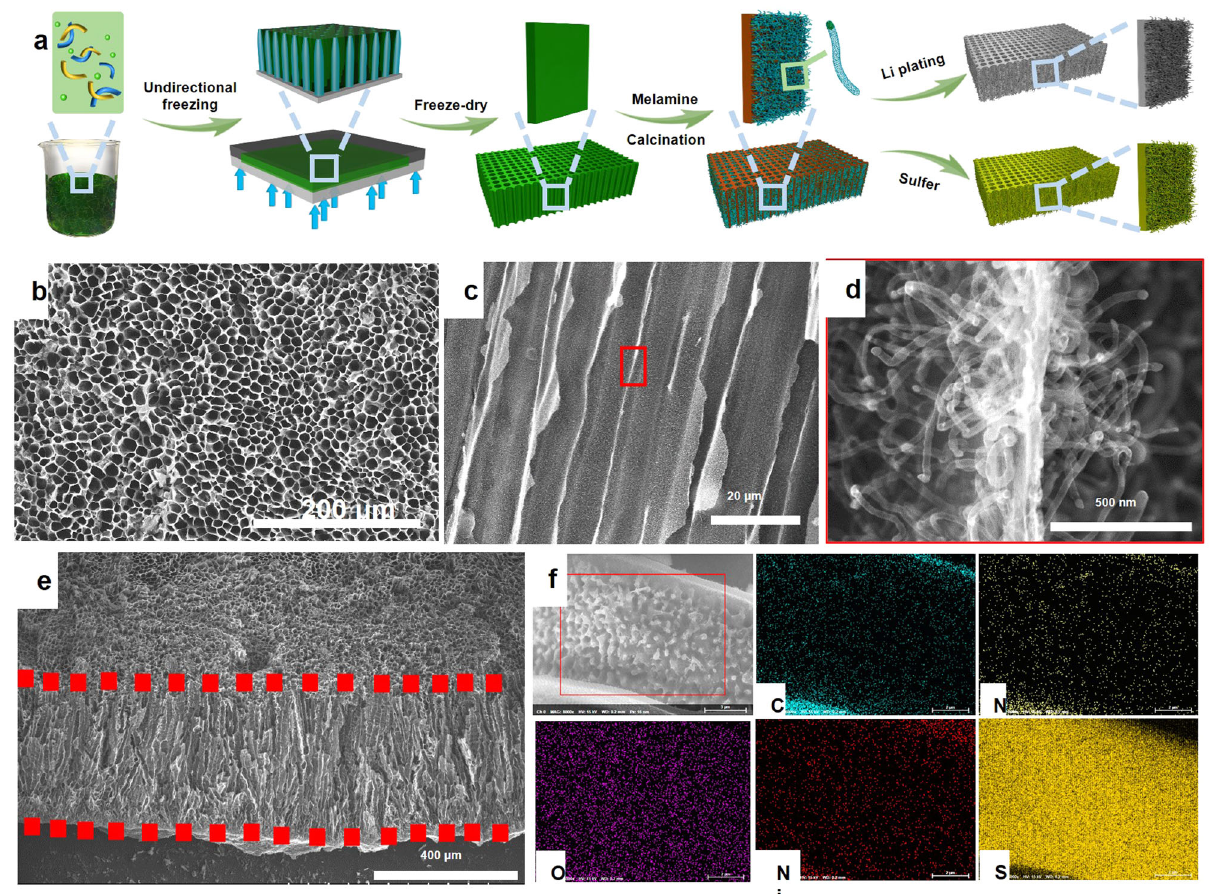
Fig. 1 The fabrication process and design principle for S@WLC-CNTs electrodes. a Schematic illustration of the synthesis process, b − d Scanning electron microscope (SEM) images of the WLC-CNTs host. e , f SEM image with corresponding energy dispersive spectroscopy (EDS) maps of the S@WLC-CNTs cathode with sulfur loading of 17.3 mg cm − 2